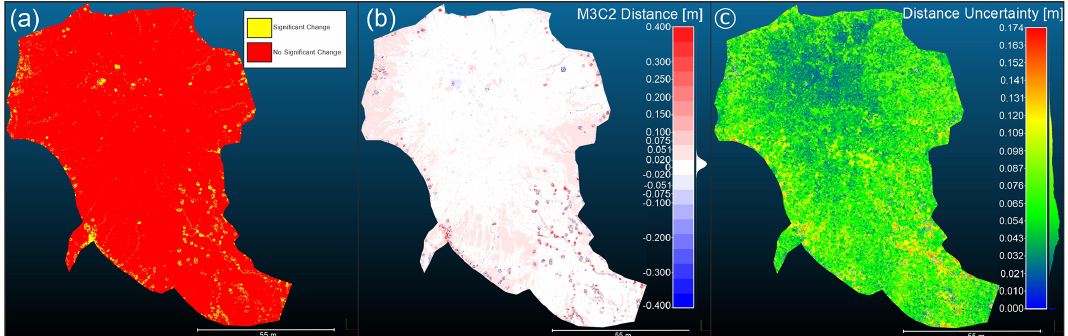
Figure 9. Estimates of the 3D error of the dense point cloud obtained by interpolation with the sparse cloud of the 13 September 2019 survey. The error (sX, sY, sZ) is in millimeters. (a) and (b) The horizontal errors ( X and Y component) are shown. (c) The vertical errors ( Z component) are shown. The reference system is WGS 84/UTM zone 33N.